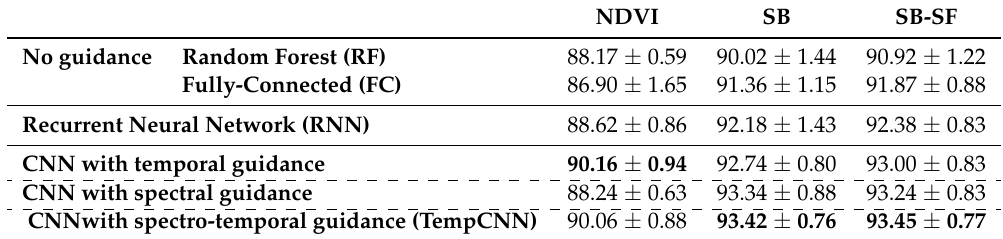
Table 3. Averaged overall accuracy ( ± one standard deviation) over five folds for four levels of help in spectral and/or temporal dimensions. Three feature vectors are used here: (1) Normalized Difference vegetation index (NDVI), (2) spectral bands (SB), and (3) SB and three spectral features (SB-SF). Bold values show the highest performance for each type of features. CNN/ COnvolutional Neural Network. NDVI SB SB-SF No guidance Random Forest (RF) 88.17 ± 0.59 90.02 ± 1.44 90.92 ± 1.22 Fully-Connected (FC) 86.90 ± 1.65 Recurrent Neural Network (RNN) 88.62 ± 0.86 CNN with temporal guidance 90.16 ±